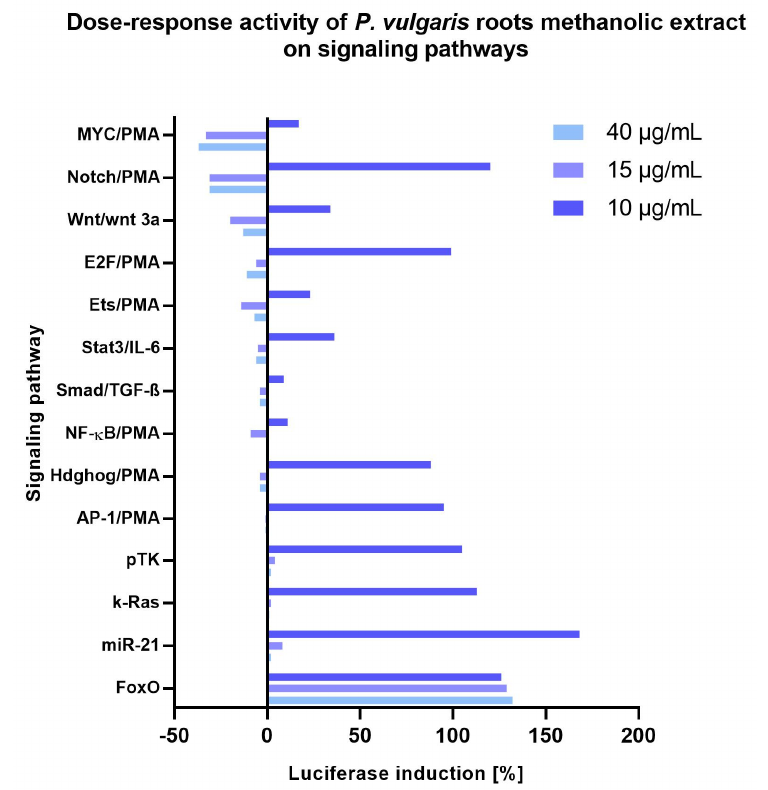
Figure 6. The active compounds from the roots methanolic extract of P. vulgaris against cancer − related signaling pathways in HeLa cells with different concentrations of 40 µ g/mL, 15 µ g/mL, and 10 µg/mL.